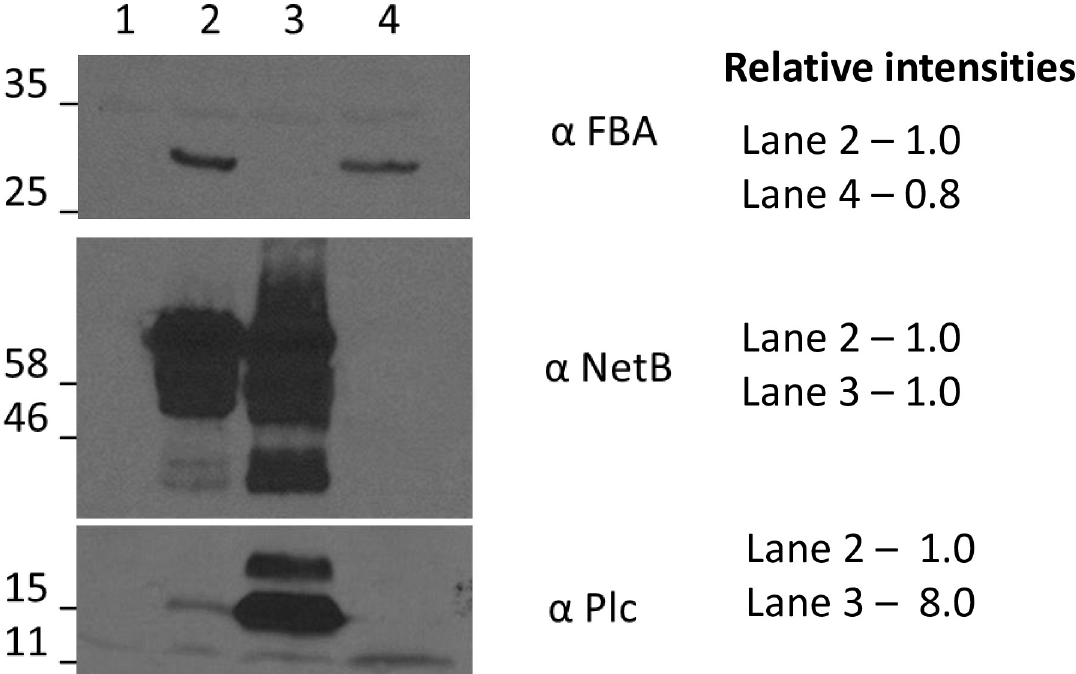
Fig 1. Antigen production by vaccine strains as determined by western blot. Vaccine strains were grown in LB as described in Materials and Methods. Antigen production was induced by the addition of IPTG four hours prior to harvest. The blots were probed with the indicated anti-sera. Predicted mass of antigens are: PlcC, 18kDa; GST-NetB, 59 kDa; Fba, 30 kDa. Lane 1, Salmonella vector control; Lane 2, Salmonella strain carrying pYA5130 ( plcC , fba , netB ); Lane 3, Salmonella strain carrying pYA5112 ( plcC , netB ); Lane 4, Salmonella strain carrying pKR023 ( fba